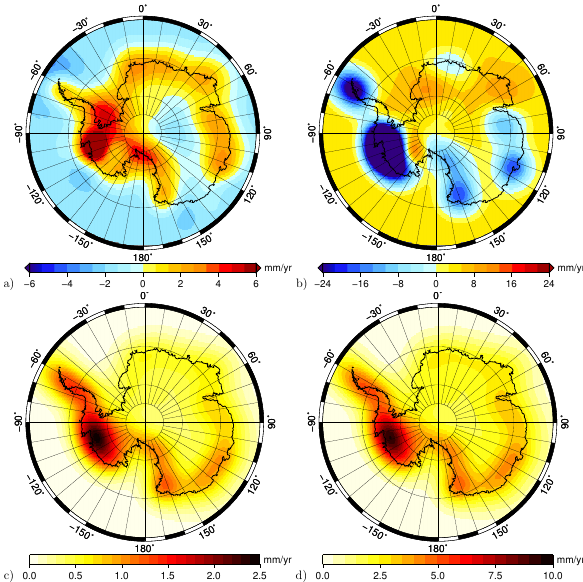
Fig. 9. Estimates (a, b) and uncertainties (c, d) for the empirically derived GIA rates (a, c) in mm · yr − 1 and ice mass change rates (b, d) in mm EWH · yr − 1 , using the representative case CSR RL04 DDK3.